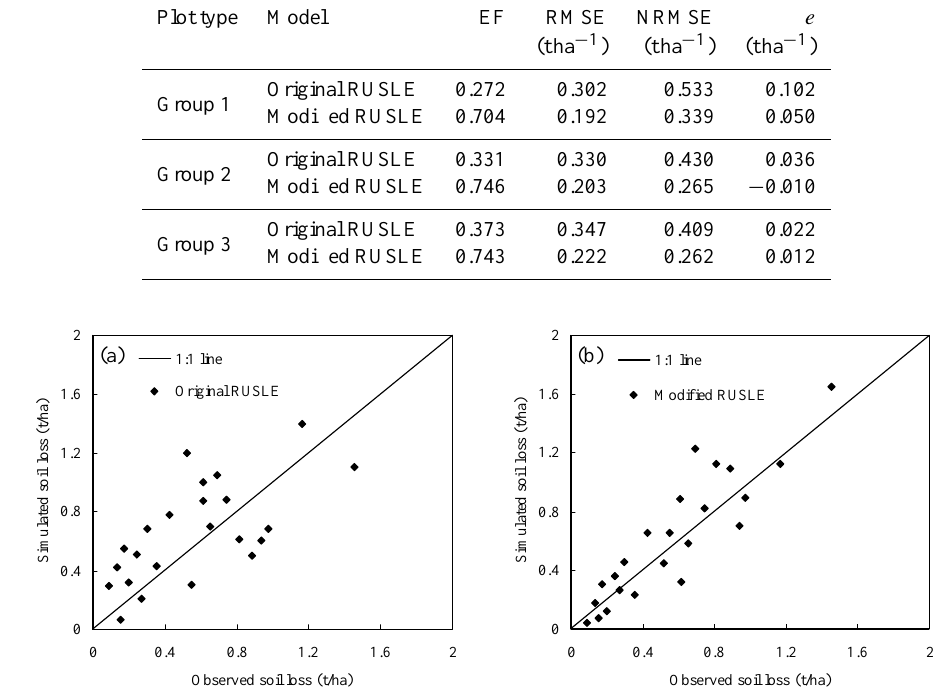
Fig. 7. Comparison between observed and predicted event soil loss during 2009–2011 using (a) original RUSLE and (b) modified RUSLE models for Group 1 runoff plots